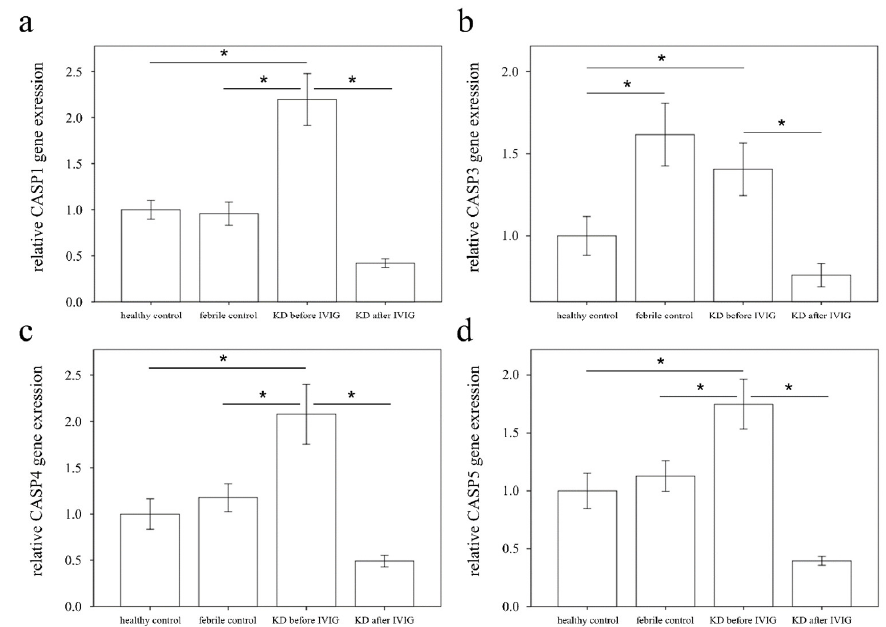
Figure 3. Analyses of CASP1 ( a ), CASP3 ( b ), CASP4 ( c ), and CASP5 ( d ) in the peripheral white blood cells of 46 Kawasaki disease (KD) patients before and after intravenous immunoglobin treatment (IVIG) as well as 44 healthy and 44 febrile controls using a real-time quantitative polymerase chain reaction. Data are expressed as mean ± standard error. Data analyzed by one way ANOVA and Fisher’s LSD multiple comparisons. * indicates significance ( p < 0.05) between the groups.